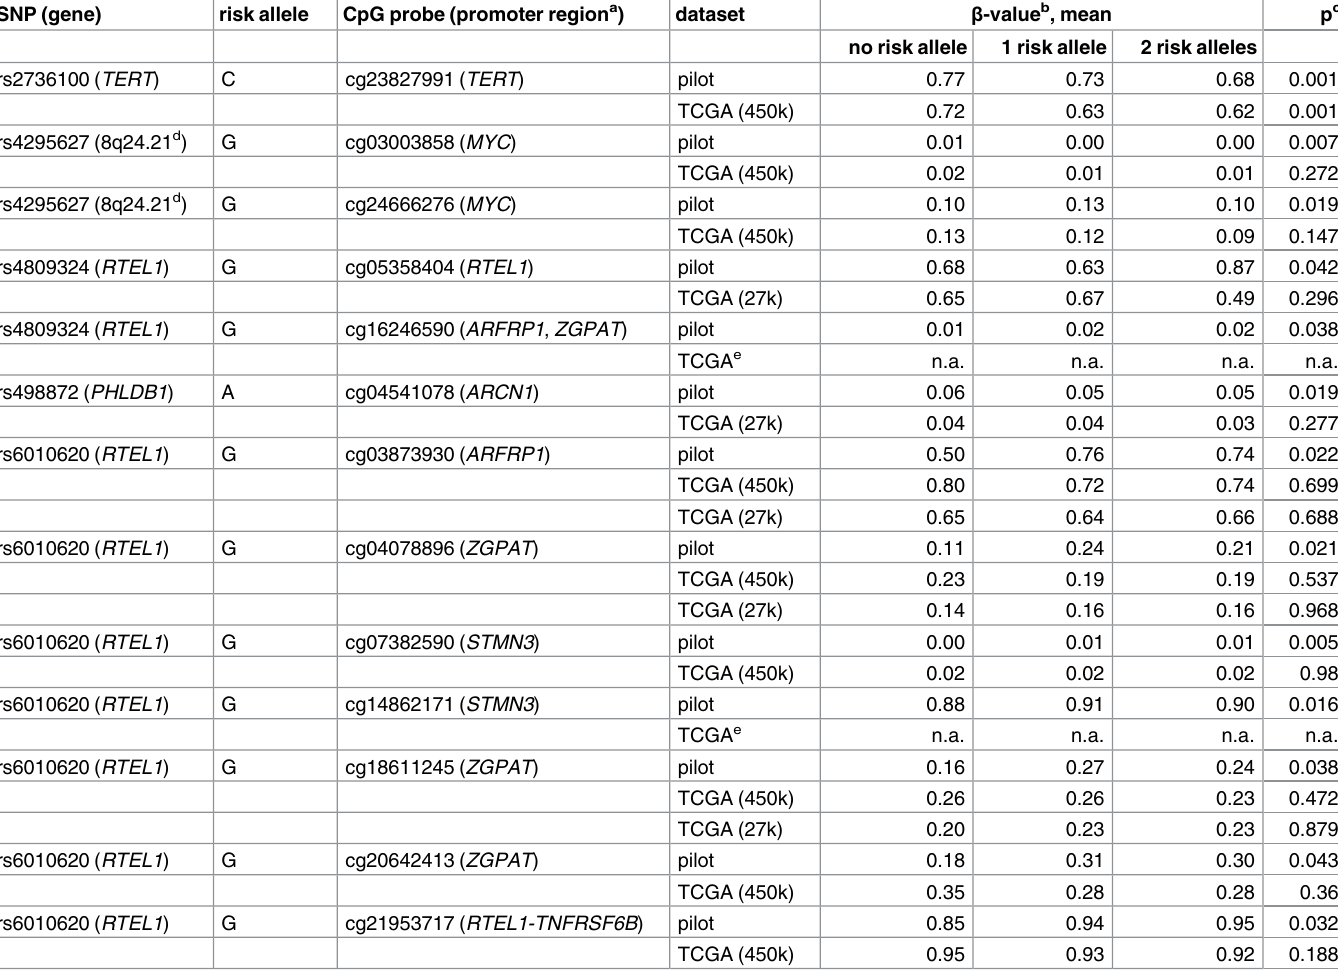
Table 2. Associations between glioma risk SNPs and CpG probe methylation with p < 0.05 in the pilot dataset. SNP (gene) risk